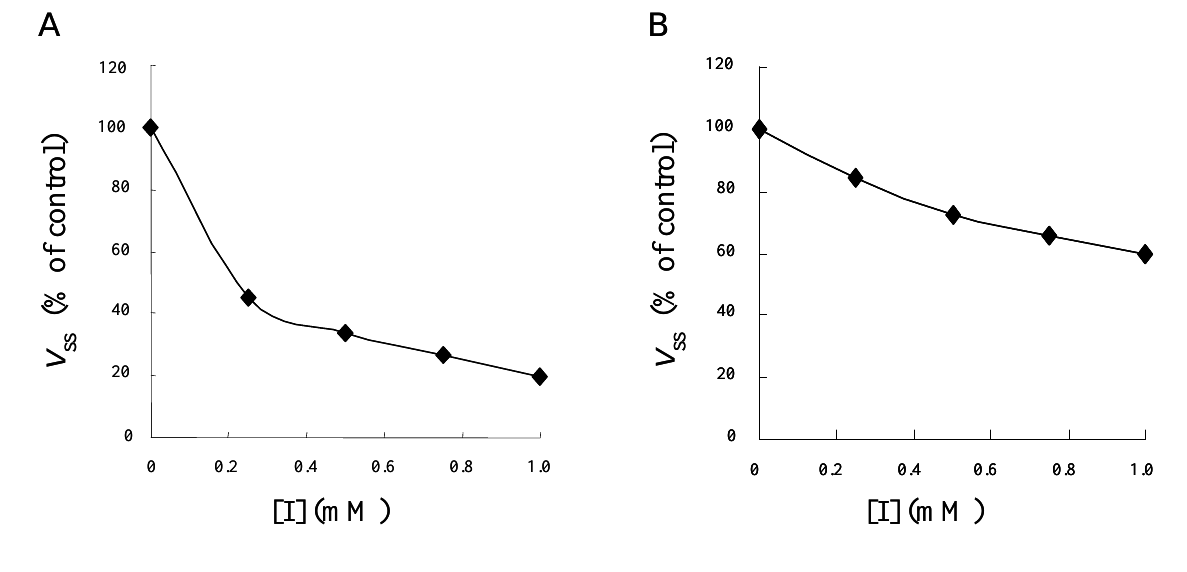
Figure 4. Relationship of the steady-state rate with the concentration of diflunisal ( A ) and indomethacin ( B ) L -tyrosine was incubated with mushroom tyrosinase with or without diflunisal or indomethacin as described in Experimental